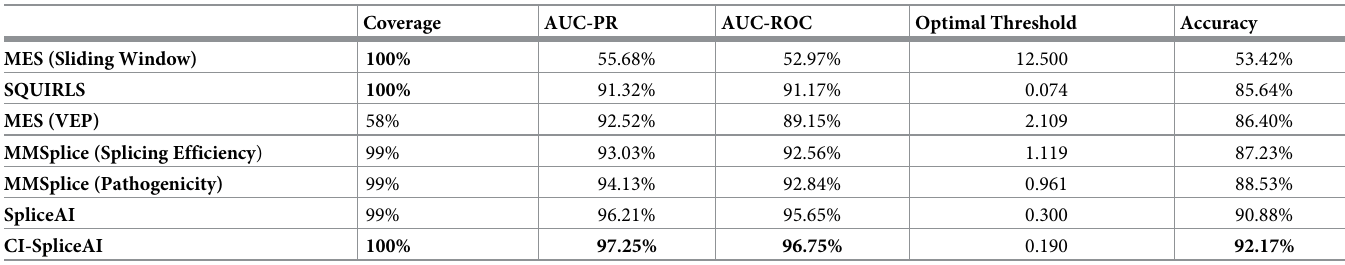
Table 2. Binary classification results on the variant data (affecting/non